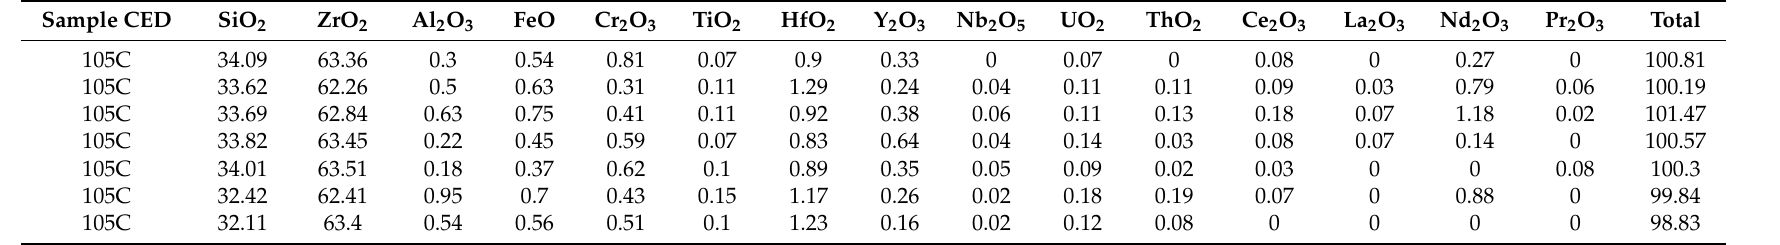
Table 4. Selection of representative electron microprobe analyses of zircon from Cedrolina chromitite (wt %).